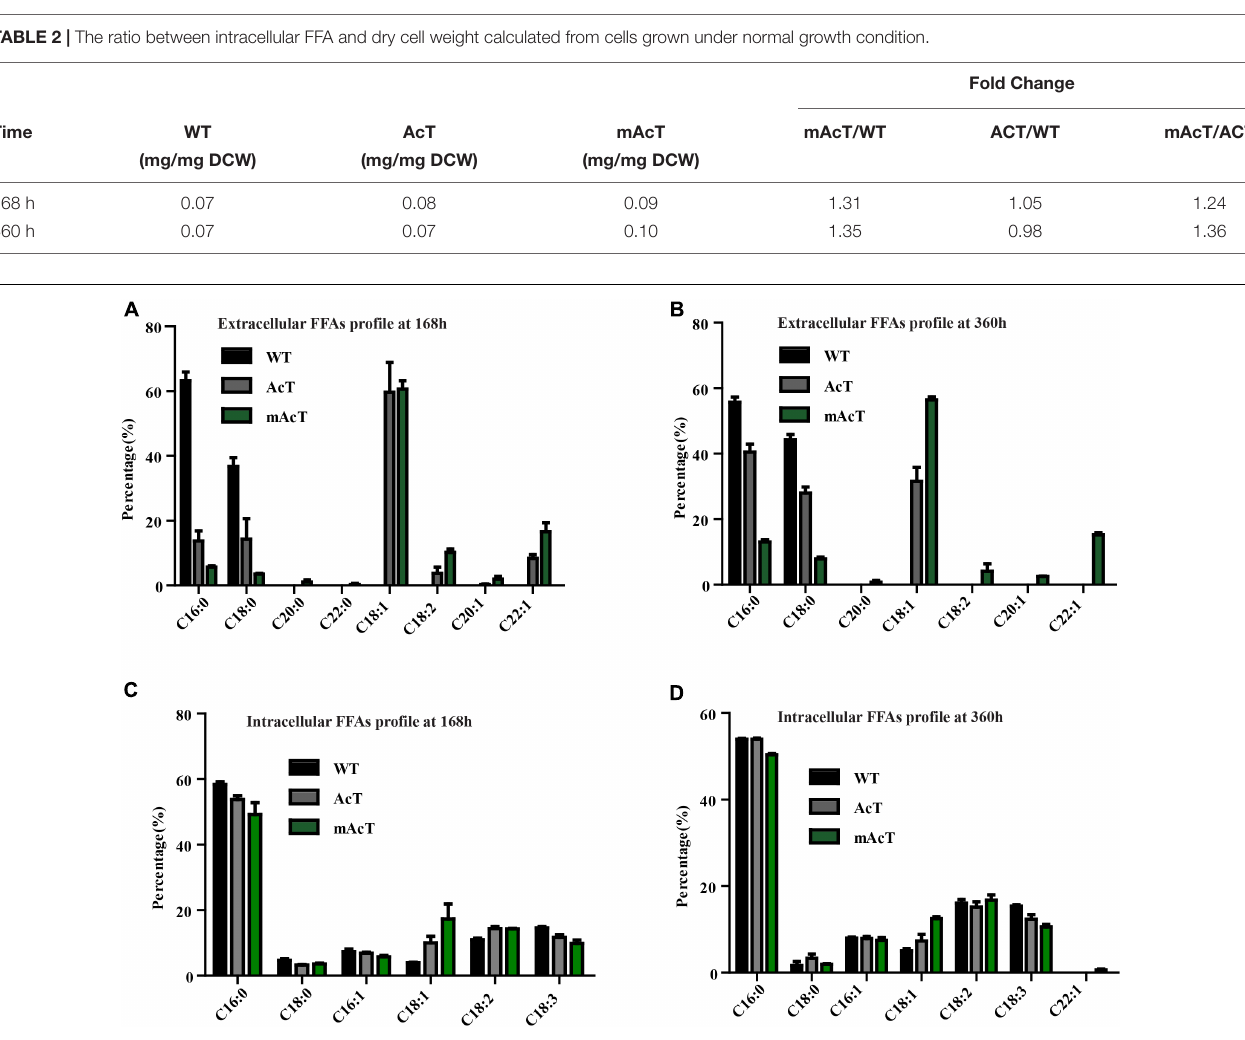
FIGURE 3 | Fatty acid profile of FFA-producing strain. Cultures were grown at 30 ◦ C in a BG-11 medium under continuous illumination of 25 µ mol photons m − 2 s − 1 light. FFA compositions were analyzed by GC-MS. (A) Extracellular FFA profile at 168 h, (B) extracellular FFA profile at 360 h, (C) intracellular FFA profile at 168 h and (D) intracellular FFA profile at 360 h. Data shown here are the mean ± SE from biological triplicates.